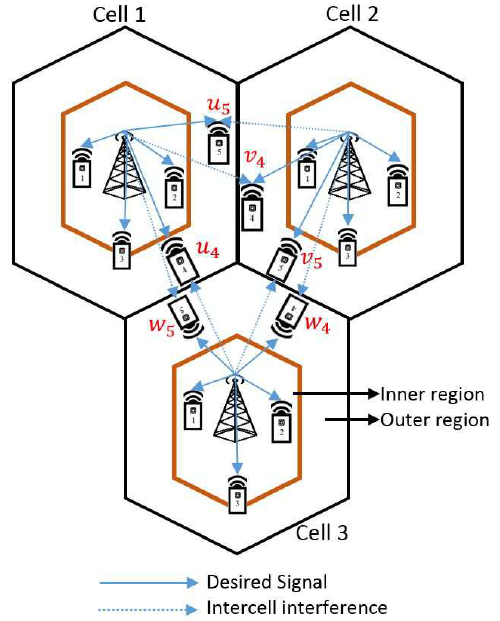
Figure 4. Multiple-input-multiple-output Gaussian interference channel for five users per cell ( K = 5 and L = 3), MUs: {1, 2} cell-centre users, three cell-median user and {4, 5} cell-edge